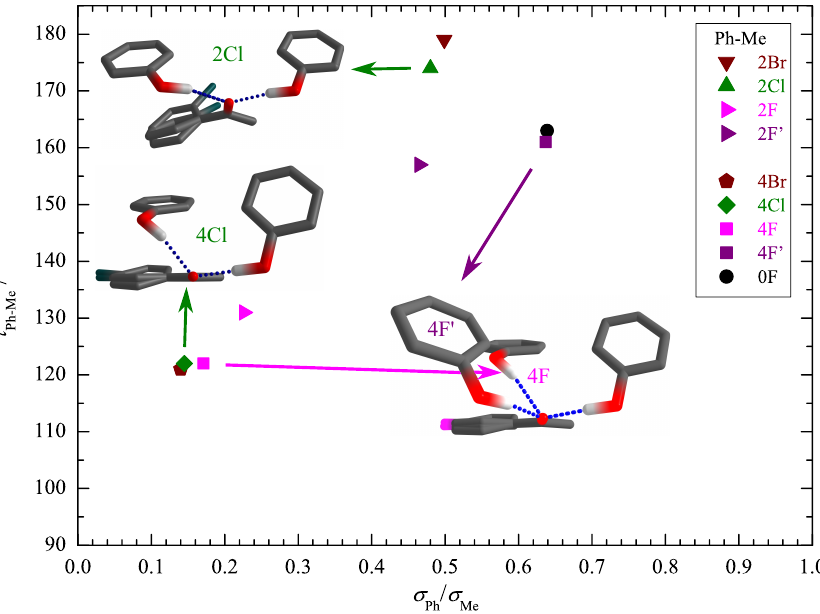
Figure 5. Correlation of the HO=CC Ph torsion angle difference for the two docking variants τ Ph-Me (see Table S2 in the Supporting Information for the individual angles) with the theoretical intensity ratio σ Ph . Strong out-of-plane placement in phenyl docking correlates with low IR visibility, whereas σ Me the methyl docking site behaves more